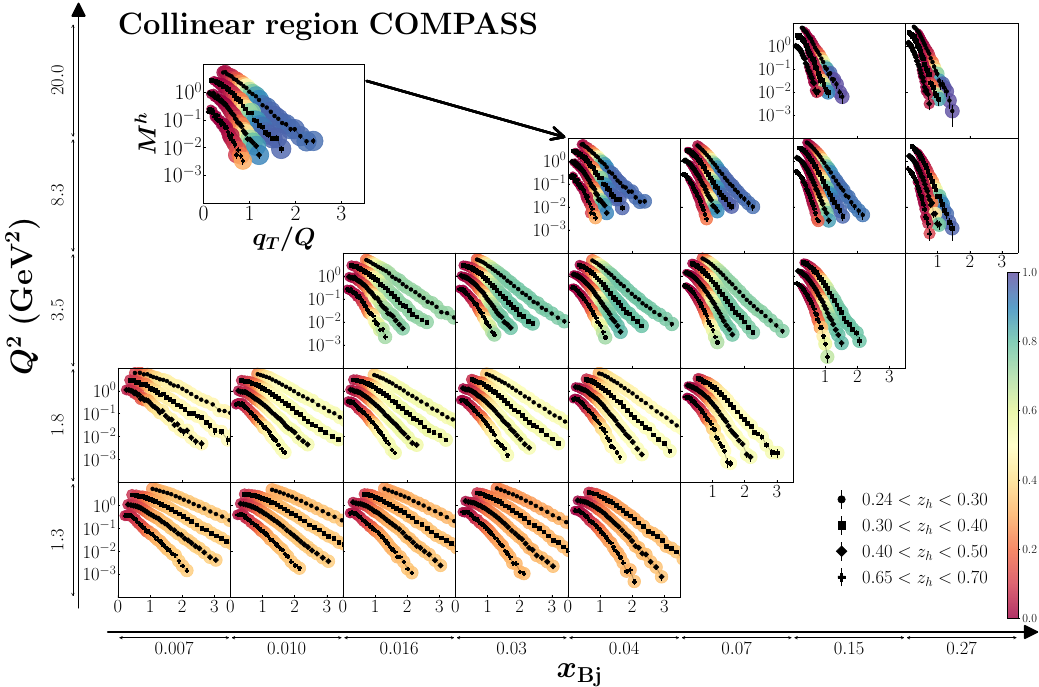
Figure 10 . Collinear region for COMPASS multiplicities [45]. The data (black symbols) on M h for h + obtained in muon-deuteron SIDIS are shown as a function of q up to four bins in z , with the dataset at the top (bottom) corresponding to the lowest (highest) h range in z and vice h